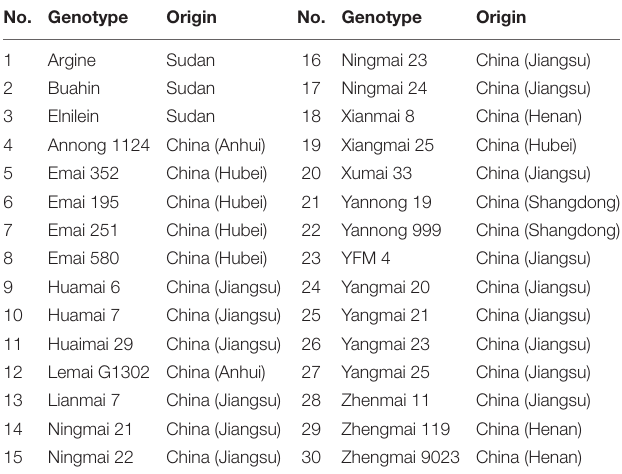
TABLE 1 | The list of wheat varieties used in this study.